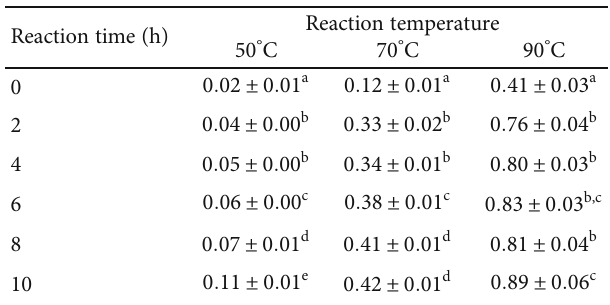
Table 1: Changes in reducing power of BSFL-Glu conjugates as a function of reaction time and temperature